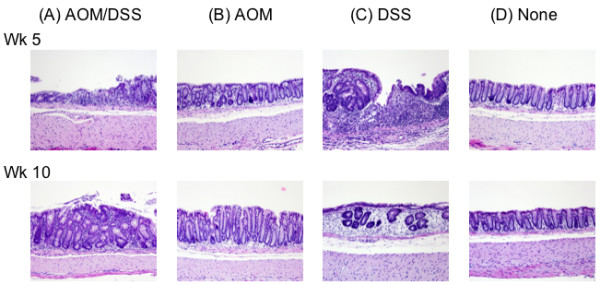
Histopathology of colonic mucosa. Colon from mice that received (A) AOM and 2%